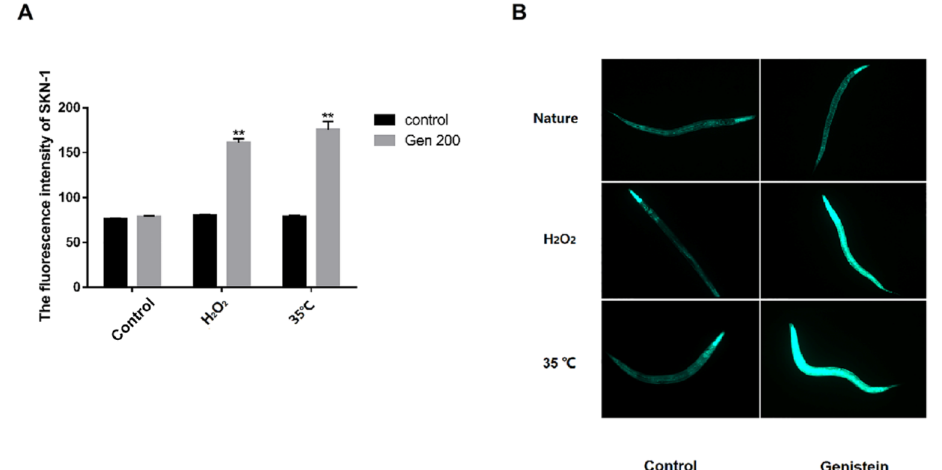
Figure 7. The accumulation of SKN-1 protein in the stage L4 C. elegans under control, H 2 O 2 , and 35 ◦ C conditions is influenced by 200 µ M genistein. ( A ) The effect of genistein on the relative fluorescence intensity of SKN-1::GFP in C. elegans . ( B ) Micrograph of SKN-1::GFP fluorescence in C. elegans ( ** p <